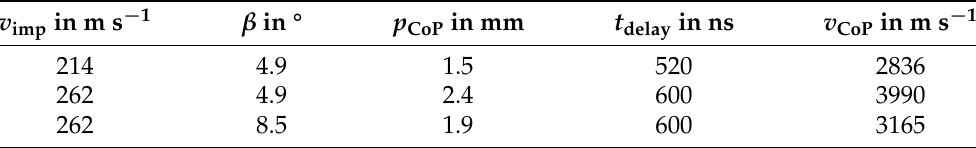
Table 3. The velocity of the CoP v CoP at different impact velocities v imp and collision angles β . It was calculated by the averaged progression p CoP of pikes of the CoP between two sequenced high-speed images with a frame delay t delay in Figure 8.